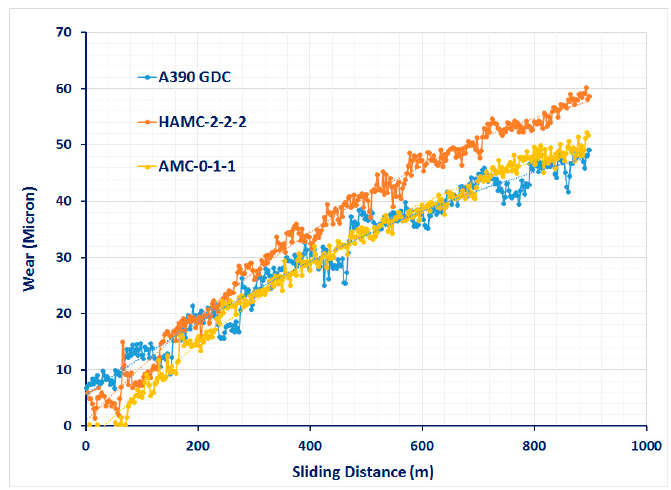
Figure 3. Wear behavior (computer generated) of a few test samples.